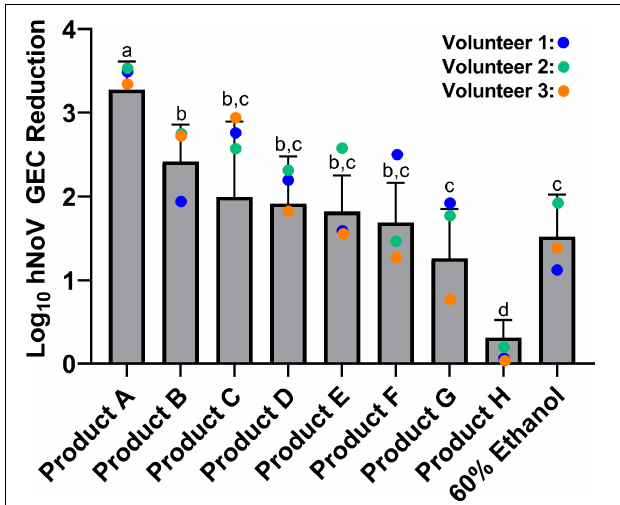
FIGURE 2 | Efficacy of eight commercially available hand sanitizer products and a 60% ethanol benchmark solution. Results from a 30 s exposure are expressed as log 10 hNoV GEC reduction ± standard deviation, as evaluated by the in vivo fingerpad assay ASTM E1838-17. Different letters indicate statistically significant differences in product efficacy ( p < 0.05) by pairwise analysis. Colored dots refer to results for the three individual volunteers who participated in the evaluation of all products